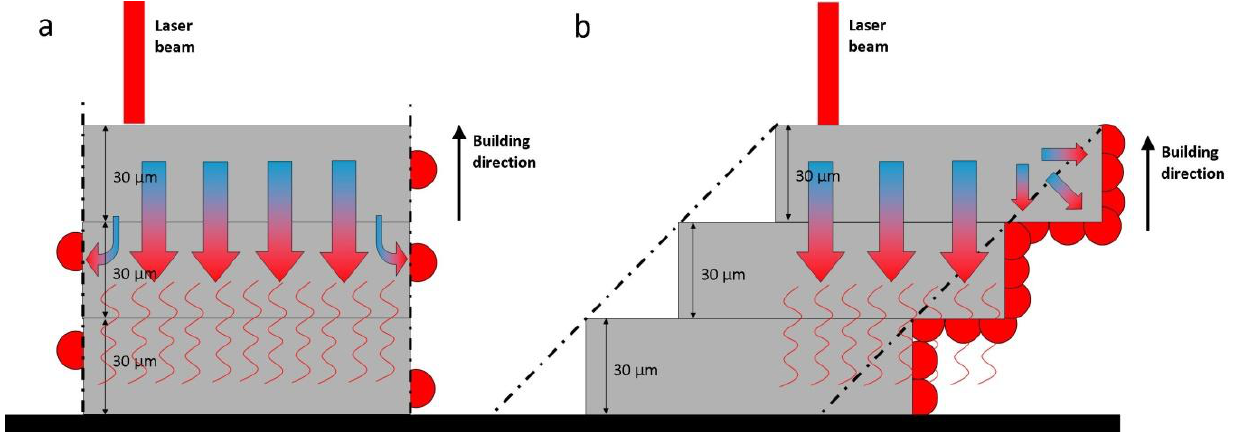
Figure 7. A visual illustration of heat flow and staircase effects for two different building angles. It highlights the increased amount of attached particles (red spheres) in relation to the building angle: ( a ) 90° building angle; ( b ) 45° building angle. The dash-dotted line corresponds to the designed beam